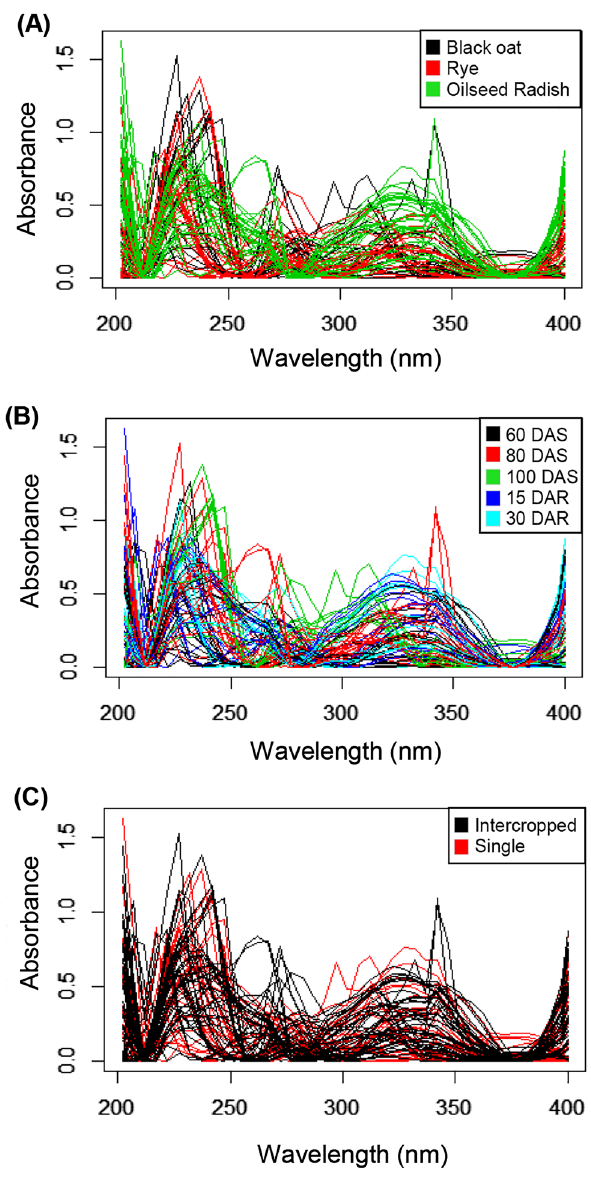
Figure 3: UV–vis spectra profiles of the methanolic extract of plant shoots in the region of 200–400 nm after pre-processing. The colors of the spectra indicate theplantspeciesblackoat( Avenastrigosa L.),rye( Secale cereale L.) and oilseed radish ( Raphanus sativus L.) (A), the periods of sampling (days after sowing-DAS and days after rolling-DAR) (B) and crop management system (single or intercropped)